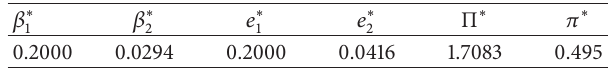
Table 4: The simulation results of asymmetric information under no fairness